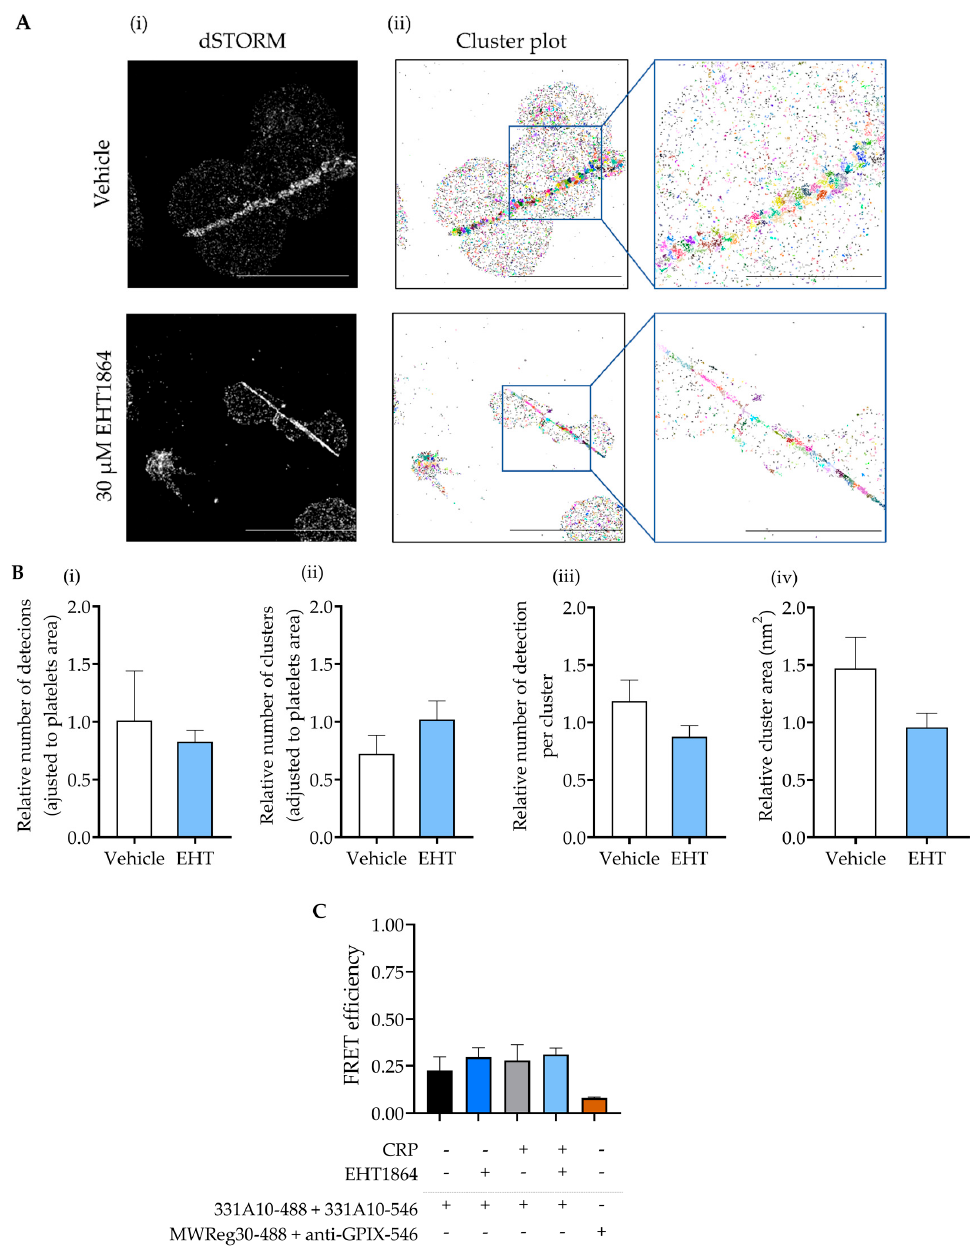
Figure 1. EHT1864 does not change GPVI receptor clustering and dimerisation on collagen. ( A ) Un- treated and EHT1864-treated human platelets labelled with 1G5-(Fab’) fragment were imaged using the NIKON N-STORM microscope and three different fields of view were captured per condition. ( Ai ) Representative dSTORM reconstructed images. The reconstruction of 20,000 frames per image was completed using the ImageJ ThunderSTORM plugin. Scale bar: 10 μ m. ( Aii ) Representative GPVI cluster plot was obtained using KNIME software with an algorithm based on density-based spatial clustering of applications with noise (DBSCAN). Scale bar: 10 μ m (left cluster plot) and 5 μ m (right magnified cluster plot). ( B ) Quantification of the effect of EHT1864 (30 μ M) on the GPVI clus- ter analysis. Relative quantification of ( Bi ) number of detections, ( Bii ) number of clusters, ( Biii ) number of detections per cluster, and ( Biv ) cluster area (in nm 2 ). ( n = 3) Mean ± SEM, by paired t- test. ( C ) FRET efficiency of GPVI on resting or CRP (10 μ g/mL) stimulated platelets, untreated or treated with EHT1864 (30 μ M) for 10 min at 37 °C, labelled with anti-human GPVI (313A10) F (ab’) fragments and as a negative control, anti-integrin α IIb β 3 and anti-GPIX antibodies ( n = 3). Mean ± SEM, by paired t -test.